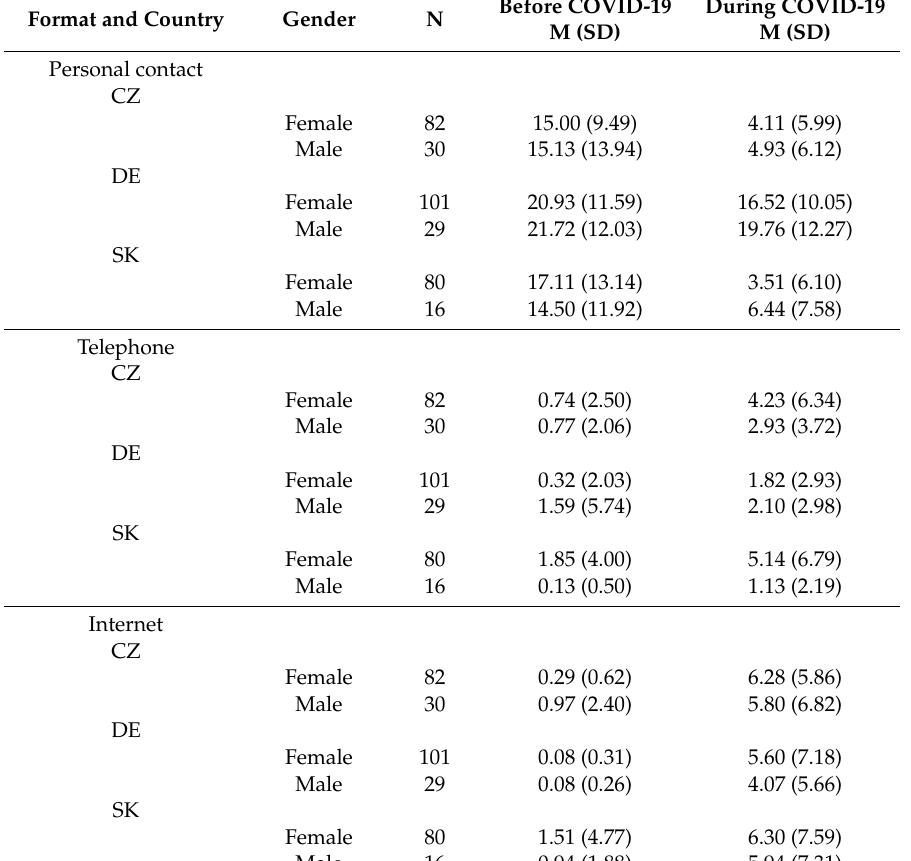
Table 4. Results of the repeated measures analysis of